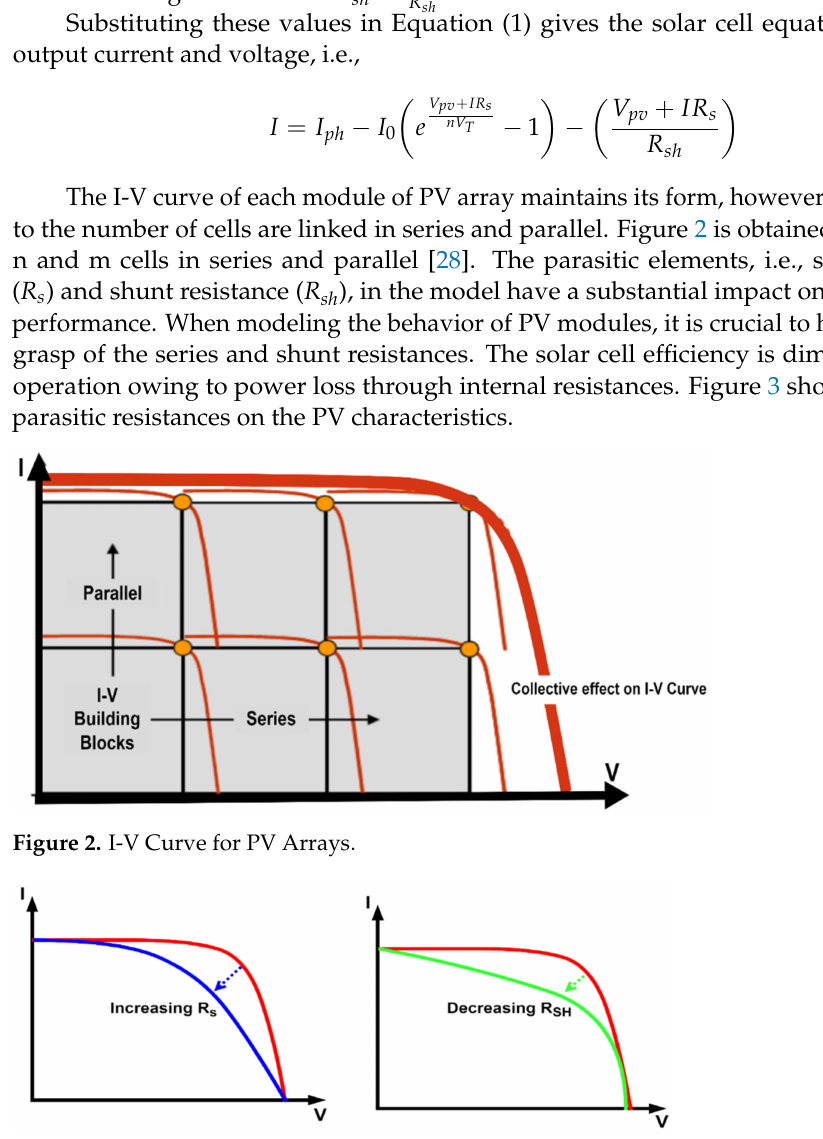
Figure 3. Effect of R s & R sh